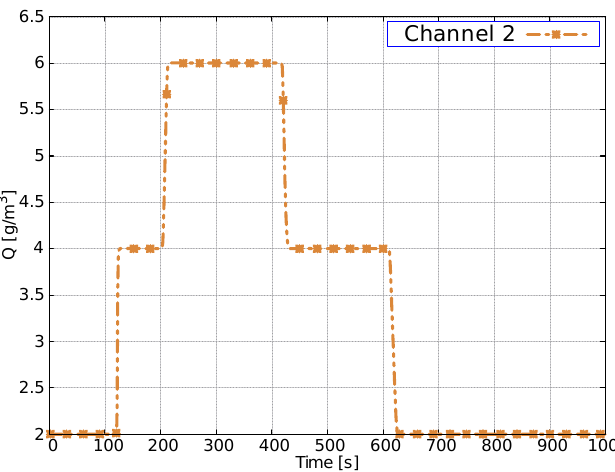
Figure 9. Case 5. Temporal evolution of flow-rate at x M ,2 = 5.5 m.